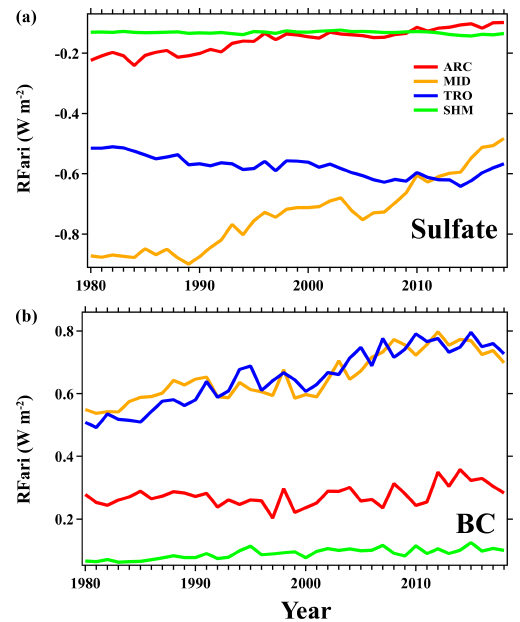
Figure 10. Time series (1980–2018) of annual radiative forcing due to aerosol–radiation interactions (RF ari ; Wm − 2 ) of sulfate and BC over the Arctic (ARC; 60–90 ◦ N), Northern Hemisphere midlati- tudes (MID; 28–60 ◦ N), tropics (TRO; 28 ◦ S–28 ◦ N) and Southern Hemisphere (SHM; 90–28 ◦